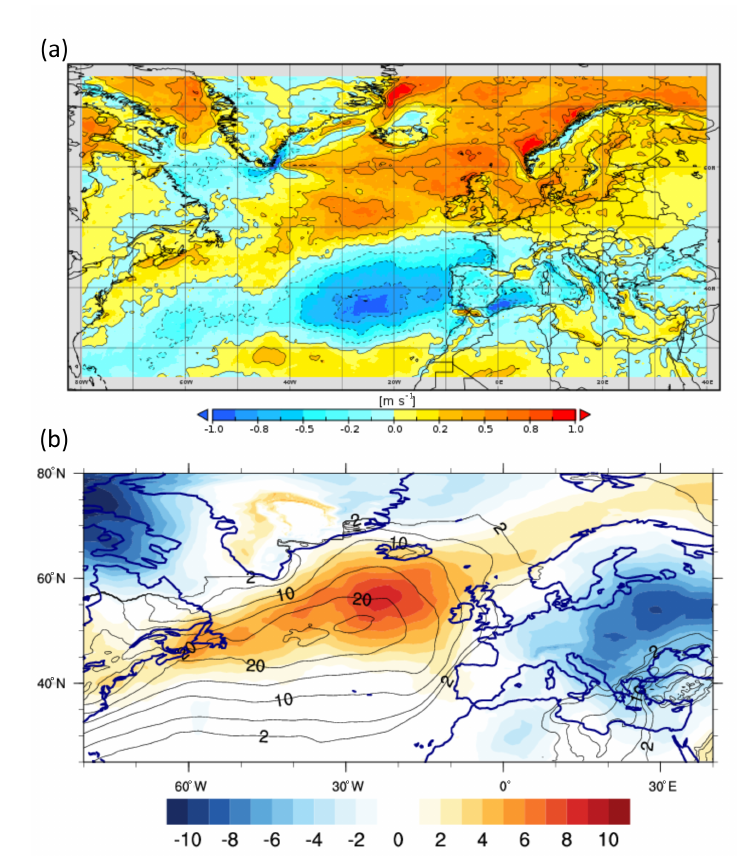
Figure 8. (a) Difference between + 2 and + 1.5 ◦ C ensemble experiments for DJF 95th daily wind percentiles, (b) DJF 700hPa transient poleward temperature flux in CAM5.1.2_0.25. Contours show the climatology derived for the period 1979–2005 (CAM5_0.25) ( ◦ Cms − 1 ); values over high orography are